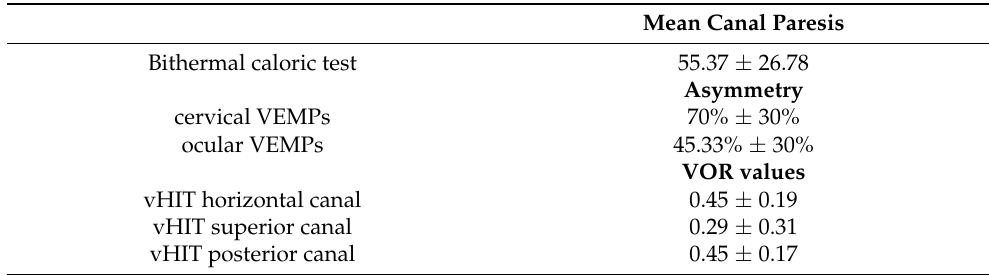
Table 1. Mean values for canal paresis, cervical and ocular VEMPs asymmetry, and vHIT gain values, depending on the affected